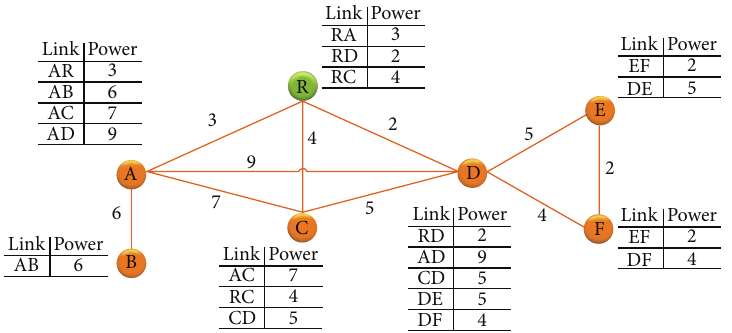
Figure 7: New link power and PCTs of the TAN in the example.